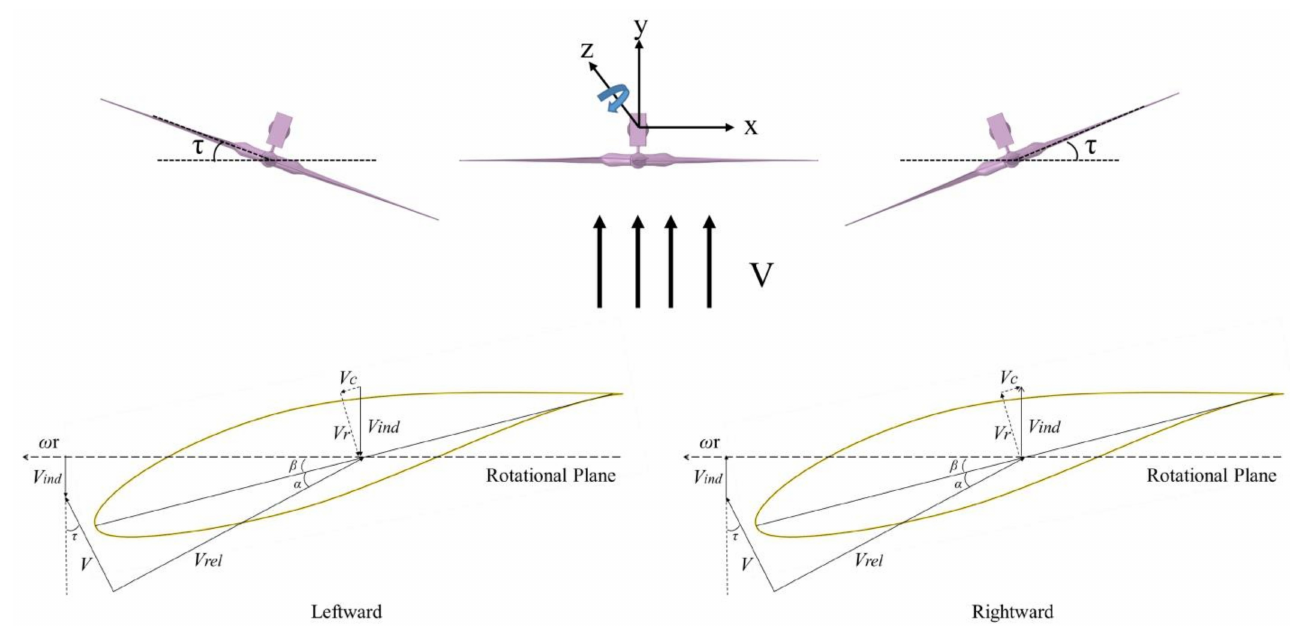
Figure 20. Schematic diagram of airfoil-induced velocity under yaw motion.